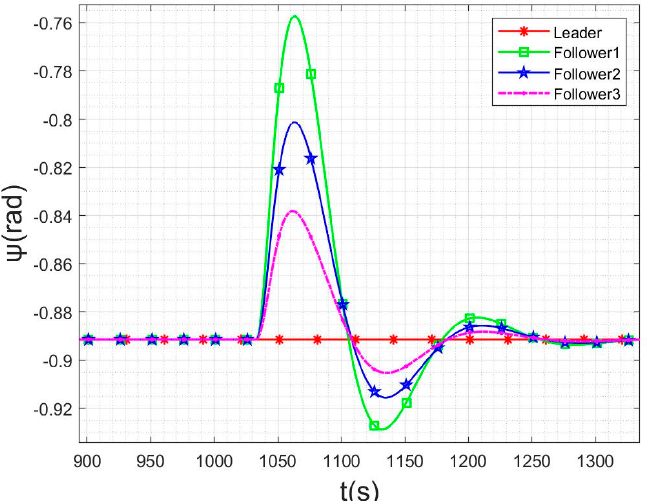
Figure 20. Heading angle information change.